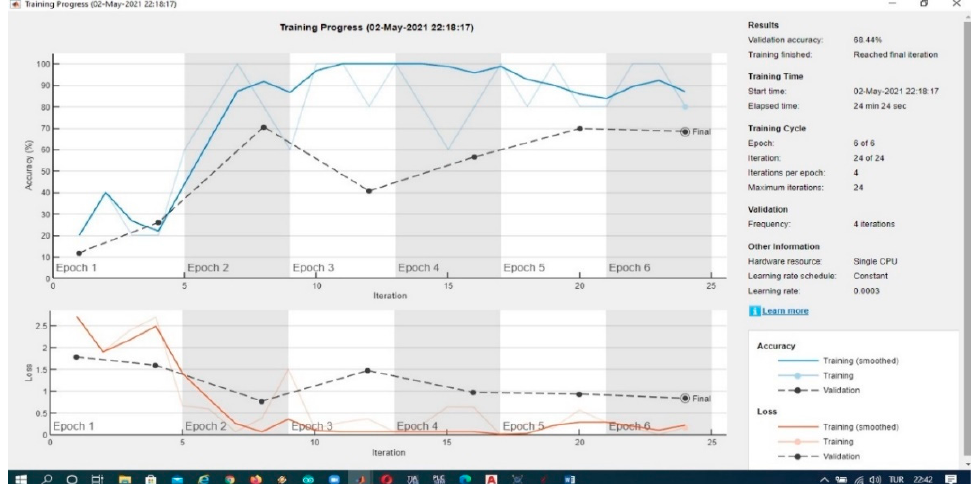
Figure 14. GoogleNet training progress.